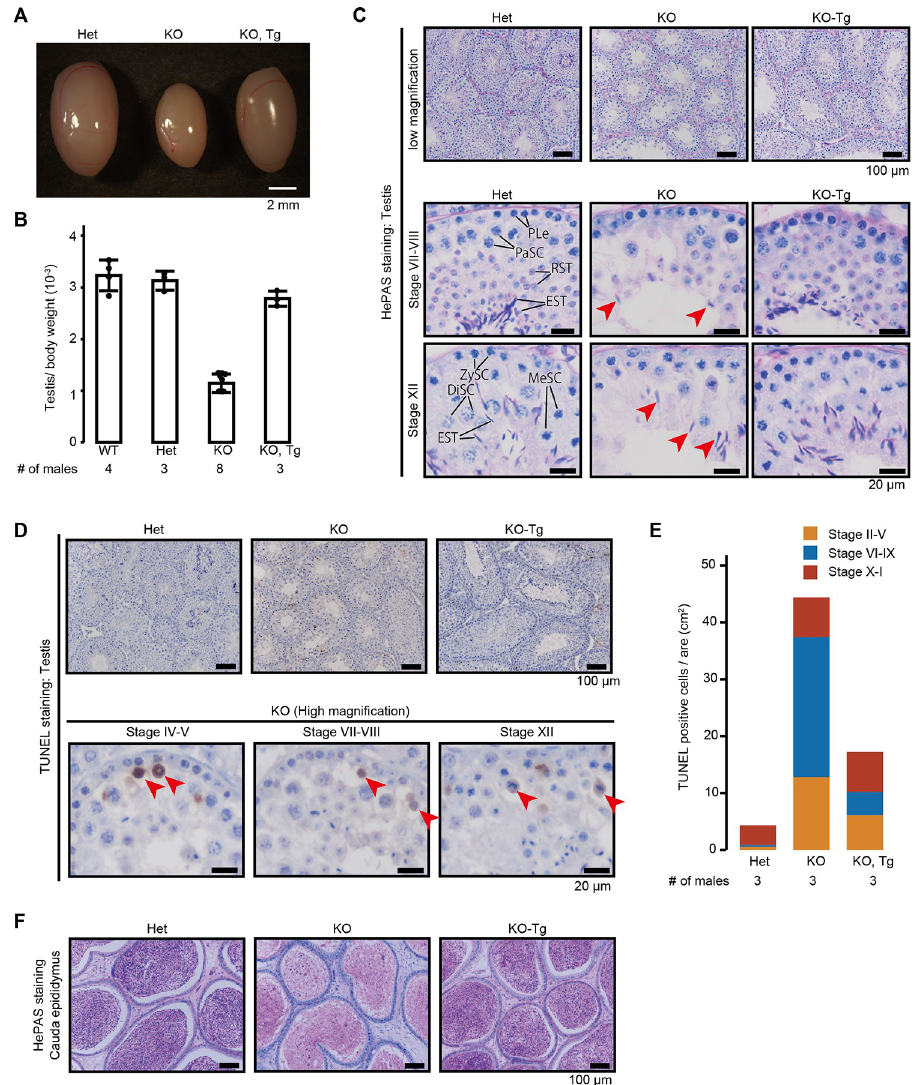
Fig 2. Histological analysis of Trim41 KO male mice. (A and B) Testis morphology (A) and testis/bodyweight of WT, Trim41 Het, Trim41 KO, and KO-Tg adult mice (B). Error bars indicate standard deviation. The numerical data are available in S3 Table (C) PAS staining of seminiferous tubules of adult mice. The seminiferous epithelium cycle was determined by germ cell position and nuclear morphology. Red arrows indicate elongated spermatids with abnormal head morphology. PLe: Preleptotene stage spermatocyte; ZySC: Zygotene stage spermatocyte; PaSC: Pachytene stage spermatocyte; DiSC: Diplotene stage spermatocyte; MeSC: metaphase spermatocyte; RST: round spermatid; EST: elongating/elongated spermatid. (D) TUNEL staining of seminiferous tubules of adult mice counterstained with hematoxylin. At least three male mice were analyzed. (E) The stacked bar graph of TUNEL positive cells. The seminiferous epithelial stages were roughly determined by the arrangement and nuclear morphology of the first layer of germ cells (spermatogonia and leptotene/zygotene stage spermatocytes). The numerical data are available in S3 Table (F) PAS staining of cauda epididymis of adult mice. At least three male mice were analyzed. 3C; white arrowheads), two SYCP3 axes on sex chromosomes (Fig 3C; yellow arrowhead), and tangled SYCP3 signals between the sex chromosome and autosomes (Fig 3C; red arrowhead). We did not observe apparent abnormalities other than in SYCP3-overloaded regions. Of note, the centerline with intense SYCP3 signals showed weak γ H2AX and DNA staining (S5C Fig;